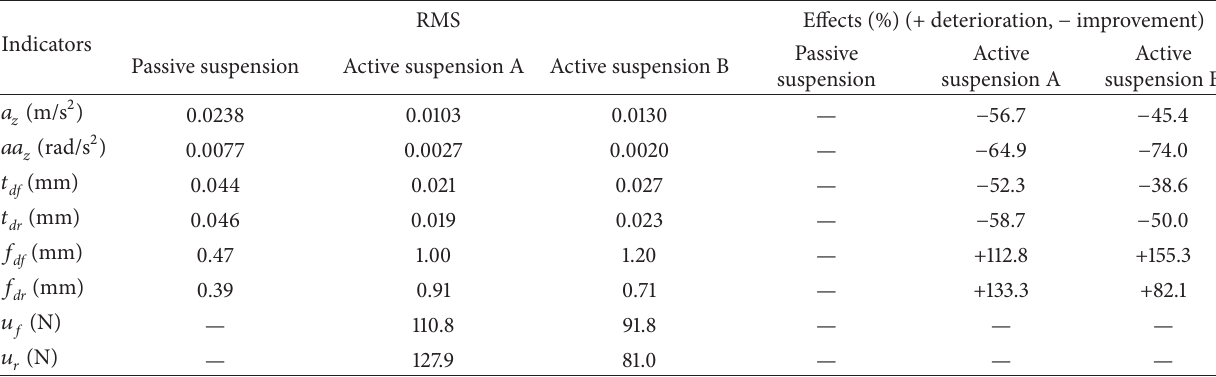
Table 2: Comparison of the root mean square values for each performance